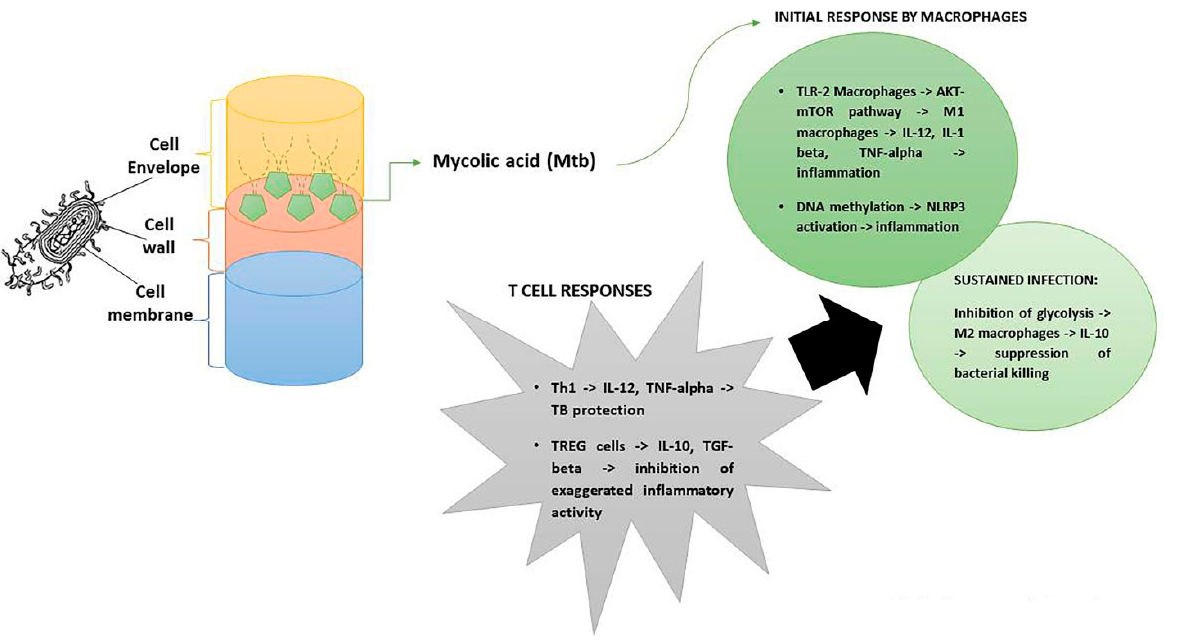
Figure 1. Immune responsiveness during TB infection. Immunity to Mtb relies on a fine balance between inflammation (M1 macrophages) and anti ‐ inflammation (M2 macrophages and TREG cells). Cytokines such as IL ‐ 12, IL ‐ 1 ‐ beta, TNF ‐ alpha, and IL ‐ 10, according to their cellular source